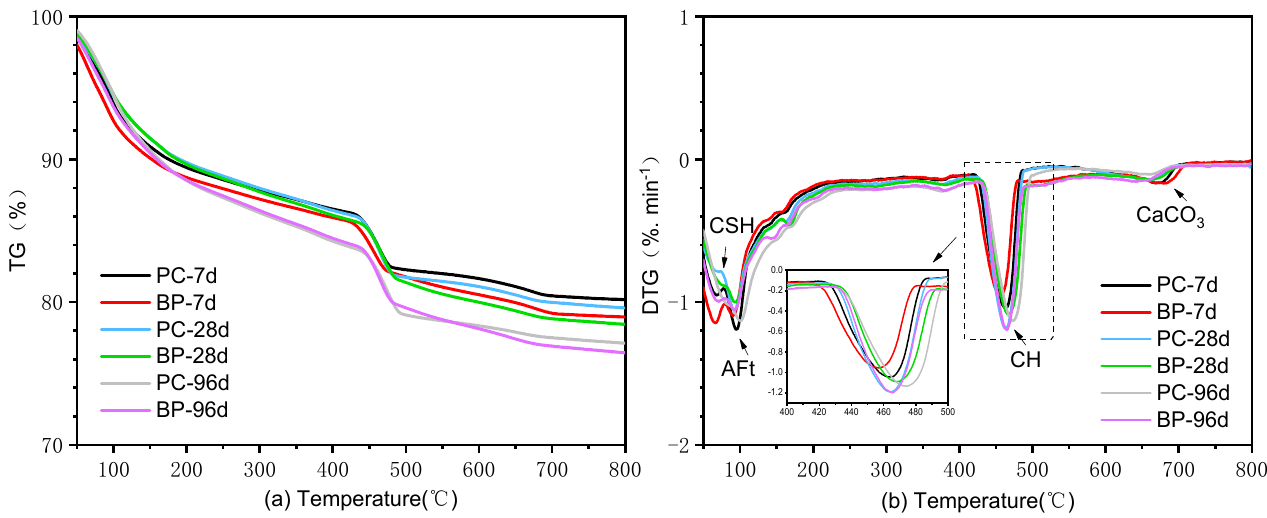
Figure 9. Weight loss of substance as a function of temperature ( a ) and weight loss rate of substance in unit time ( b ) of OPC paste and cement paste mixed BP hydration for 7, 28, and 96 d. The shear stress and viscosity vs. shear rate of OPC paste and BP paste are presented in Figure 10. As can be observed, the maximum shear stresses of OPC paste and BP paste are 207 and 299 Pa, respectively. In addition, the viscosity of the OPC paste is lower than